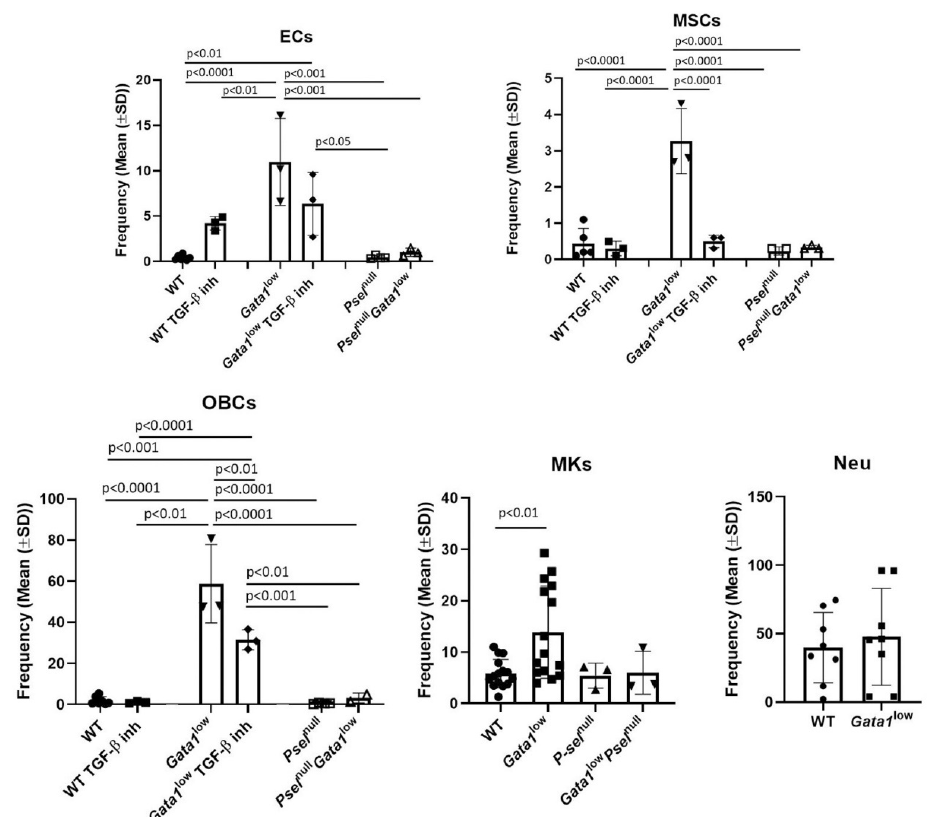
Figure 4. The bone marrow from Gata1 low mice (12–14 months of age) contains levels of endothelial cells, mesenchymal stem cells, osteoblasts, and megakaryocytes greater than those present in the bone marrow from wild-type littermates. The levels of these cells in the mutant mice were greatly reduced by treatment with a TGF- β 1 inhibitor and/or by deletion of the P-sel gene. Cells were identified according to previously described flow cytometry criteria [34,35] (see Figure S1 for the detail of the gates, Supplementary Materials). Results are presented as mean (±SD) and as values of indi- vidual mice (each dot an individual mouse). P values were calculated with Tukey multiple compar- ison and those statistically significant are indicated in the panels. Abbreviations: ECs, endothelial cells; MSCs, mesenchymal stem cells; OBCs, osteoblasts; MKs, megakaryocytes; Neu, neutrophils; WT, wild-type; Psel, Pselectin; TGF- β inh, transforming growth factors β inhibitor. The frequencies of megakaryocytes, endothelial and mesenchymal cells, and osteo- blasts in the bone marrow from Gata1 low mice are all greater than normal, while those of the neutrophils are within normal ranges (Figure 4). The greater frequency of megakaryo- cytes is consistent with previous reports [52] while that of endothelial cells and of osteo- blasts is consistent with the increased vascularization and osteogenesis observed in these mice [52,53], which recapitulate that seen in myelofibrosis patients [54]. Deletion of Psel and pharmacological inhibition of TGF- β normalized the frequency of endothelial cells, of mesenchymal cells, and osteoblasts found in Gata1 low bone marrow. These observations are consistent with the finding that deletion of Psel , probably by reducing TGF- β bioavail- ability, and inhibition of TGF- β both reduces osteopetrosis and neovascularization in Gata1 low mice [30,33,55].